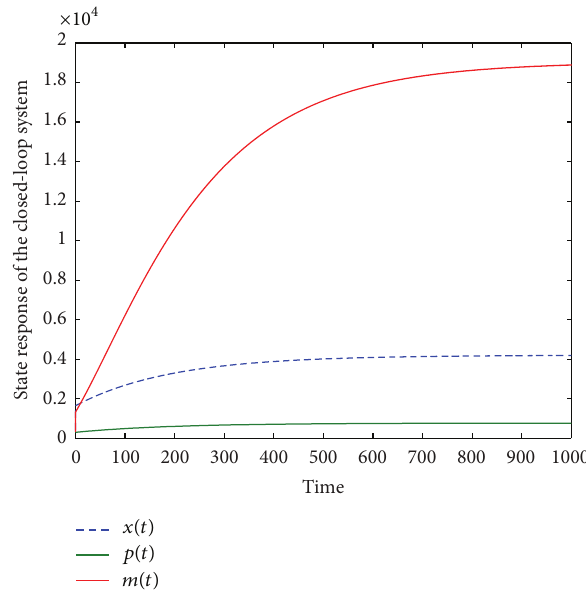
Figure 1: Trajectory of the open-loop biological economic system.